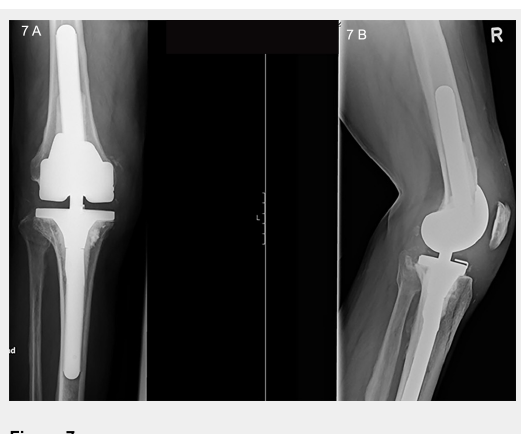
A worst-case scenario of a chronic periprosthetic infection with severe soft tissue damage.